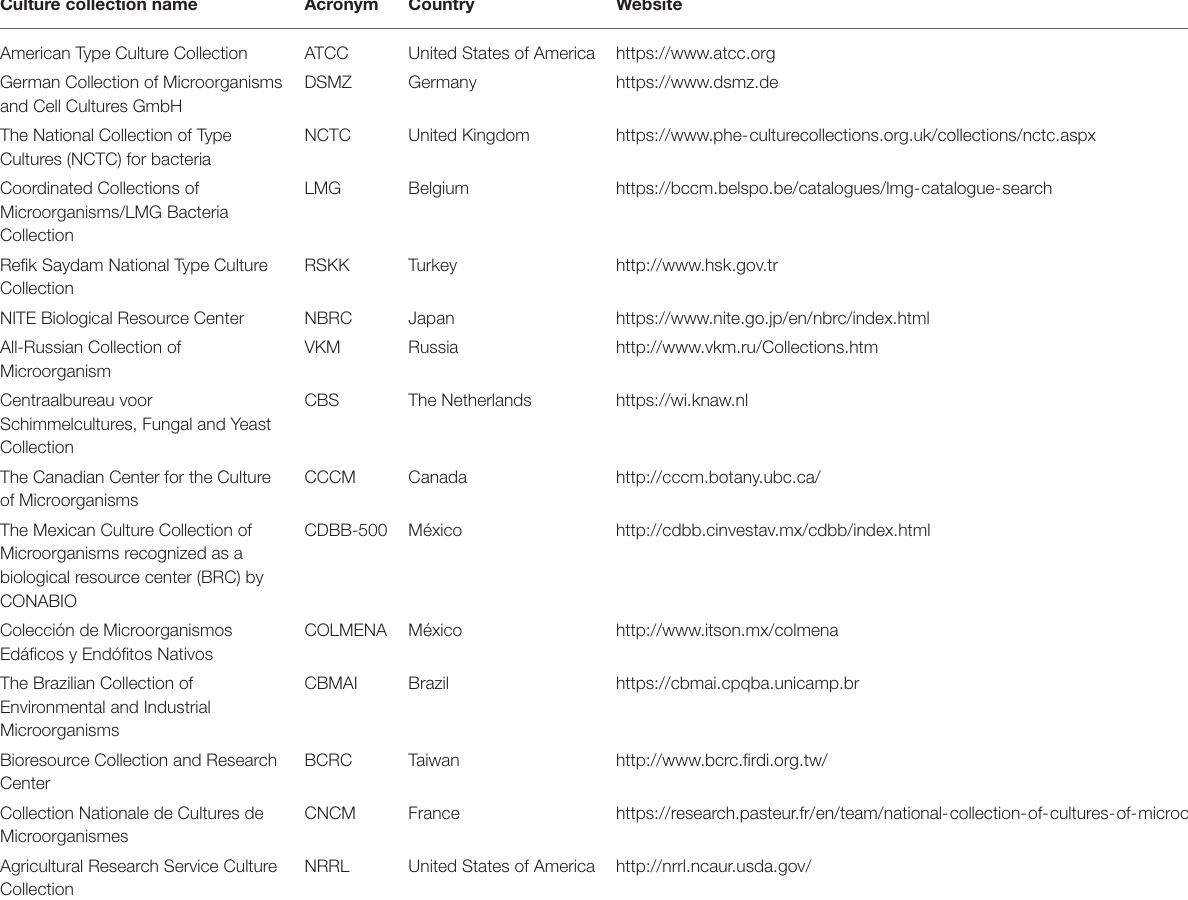
TABLE 1 | Examples of microbial culture collections around the